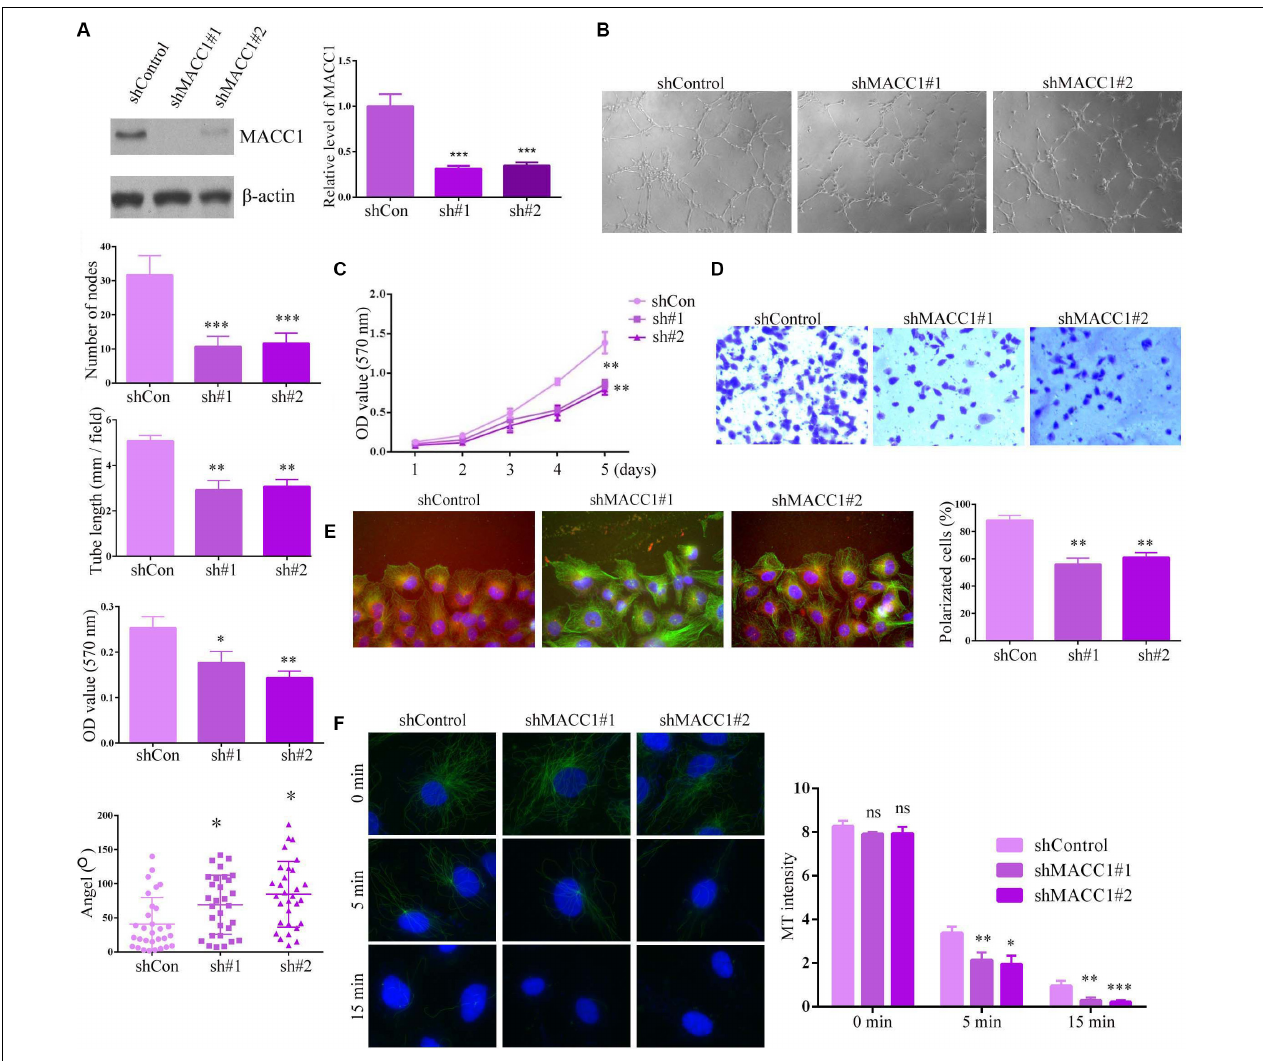
FIGURE 3 | MACC1 promotes endothelial cell angiogenesis in vitro. (A) Immunoblot assays and QPCR were performed to evaluate the protein expression of MACC1 in endothelial cells following transfection with the indicated plasmids. (B) Human umbilical vein endothelial cells (HUVECs) transfected with the indicated shRNA plasmids were plated onto Matrigel to induce tube formation, and images were obtained 3 h later. The degree of tube formation was quantified by measuring the total tube length and number of nodes. (C) Representative images of a Transwell migration assay for HUVECs transfected with the indicated shRNA plasmids, and quantification of migrated cells. (D) Representative images of wound healing in HUVECs transfected with shRNA plasmids at the indicated times, and quantification of the extent of wound closure. (E) Immunofluorescence microscopy images of HUVECs transfected with shRNA plasmids, followed by staining with DAPI, and anti- α -tubulin and anti- γ -tubulin antibodies. Scheme for the measurement of polarization angle. Polarized cells and polarization angles were quantified. (F) HUVECs were transfected with the indicated plasmids, incubated on ice to depolymerize the microtubules (MTs), followed by quantification of MT intensity. Representative immunofluorescence images are shown. Results are presented as means ± SEM; ∗ p < 0.05, ∗∗ p < 0.01, and ∗∗∗ p <